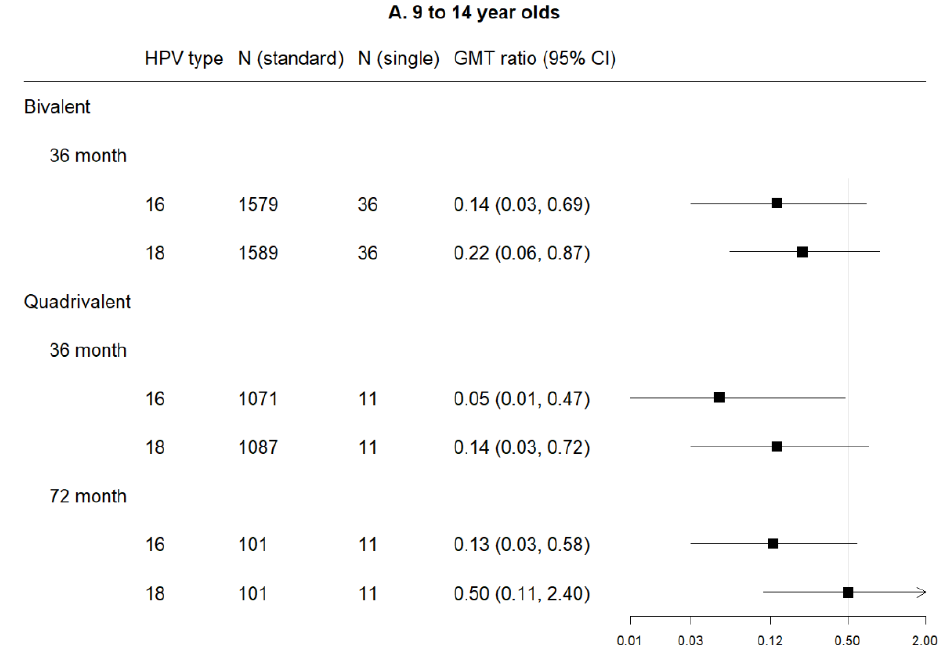
Figure 5. Forest plot of GMT ratio of single dose versus standard schedule (with 0.5 indicating the non-inferiority cut-point—i.e., those with lower bounds greater than 0.5 are considered to meet non- inferiority criteria), by vaccine, HPV subtype, and time point among ( A ) 9 to 14 year olds and ( B ) 15 to 26 year olds. 3.4.1. Bivalent Two studies reported bivalent vaccine single dose data: LaMontagne 2014 (36 months, 9–14 years) [30] and Safaeian 2018 (36- and 72-month data, 15–26 years) [10]. Non-inferiority was not met for either HPV sub-type for any of the age groups or time points. For the 9–14 year old group, at 36 months post-first dose, HPV 16 GMT estimates for standard vs. single dose were 244 IU/mL (95% CI 155–383) vs. 31 IU/mL (95% CI 9–111), and HPV 18 GMT estimates were 127 IU/mL (95% CI 88–185) vs. 16 IU/mL (95% CI 5–49). Among 15–26 year olds, HPV 16 GMT estimates for standard vs. single dose were 102 IU/mL (95% CI 70–149) vs. 28 IU/mL (95% CI 15–54) at 36 months, and 74 IU/mL (95% CI 54–102) vs. 27